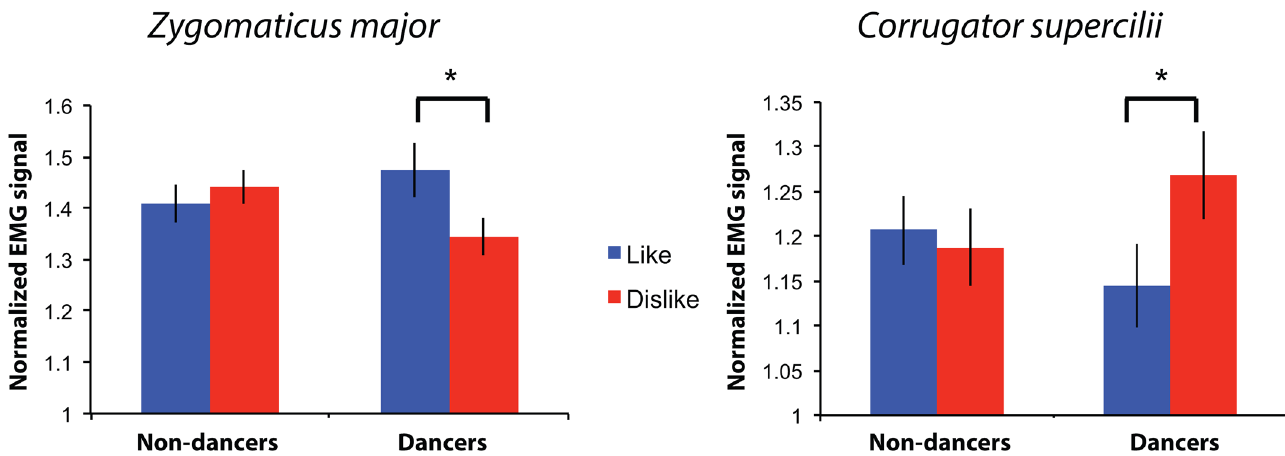
Fig 2. Normalized EMG signal, averaged across the 3s videos, by muscle, reported valence and group. The left panel illustrates the EMG signal from the zygomaticus major (ZM) muscle and right panel for the corrugator supercilii (CS) muscle. Blue bars indicate muscle activity averages for liked videos, red bars for disliked videos. An asterisk ( * ) indicates a difference significant at p < 0.05. Error bars indicate +/- 1 standard error of the mean (SEM).